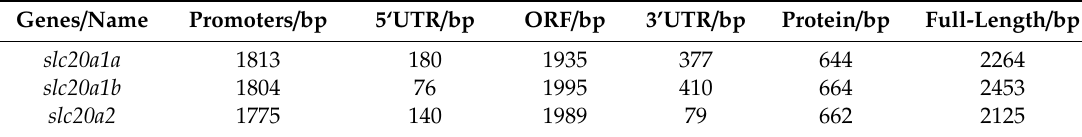
Table 1. The sequences information of three slc20s from grass carp C. idella.